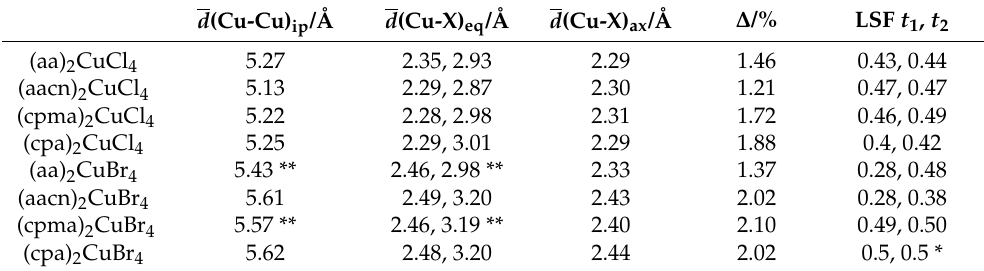
Table 1. Geometrical parameters of octahedral CuCl 6 units in the structures of prepared compounds. d (Cu-Cu) ip represents in-plane distance between the neighbouring copper ions, d (Cu-X) eq represent average in-plane (equatorial) copper-halogenide distances and d (Cu-X) ax represent average out-of- plane (axial) copper-halogenide distances, ∆ /% represents octahedral distortion [28], LSF represents layer translation values [13].